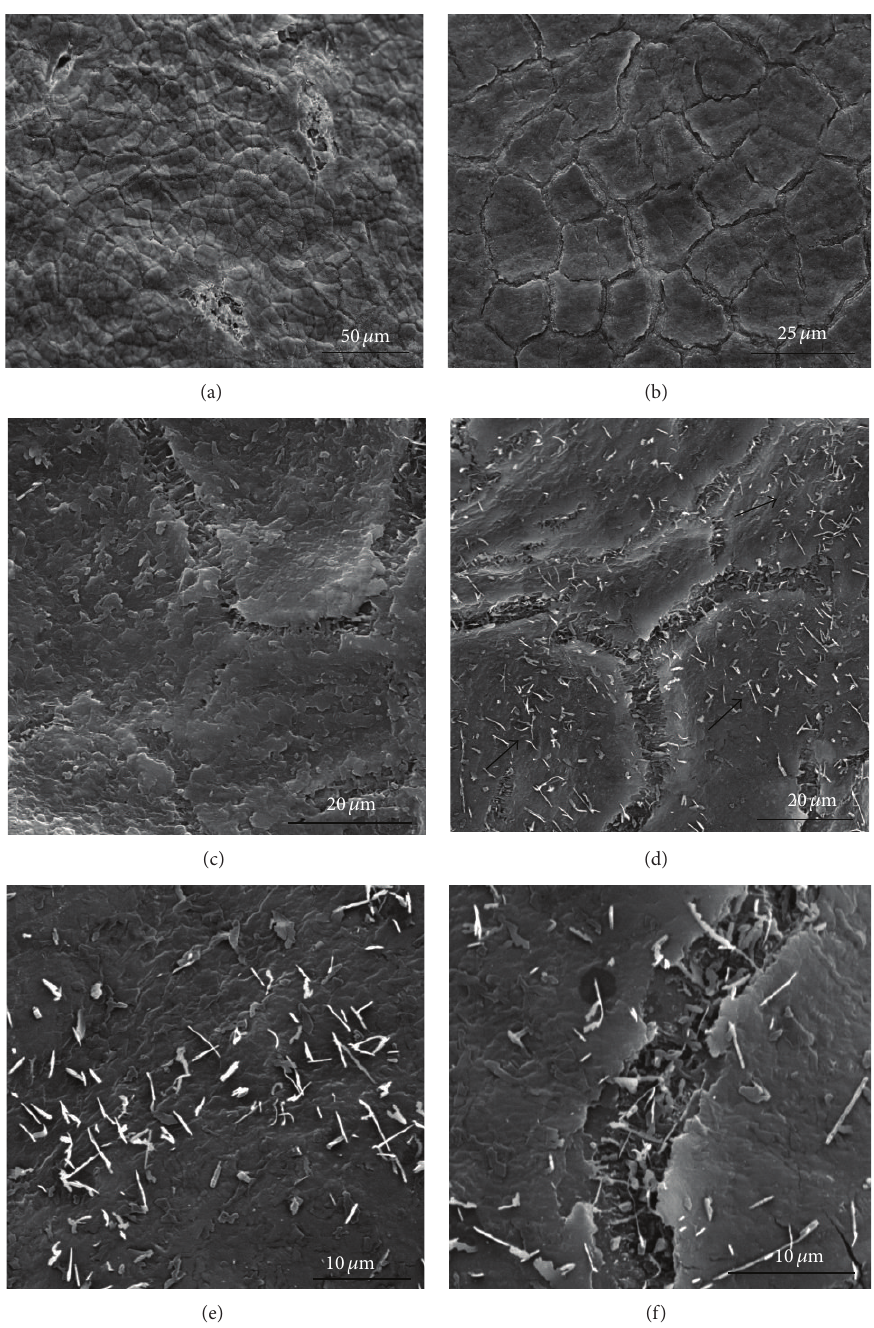
Figure 1: SEM: epidermis surface of the “Conference” ((a), (d)–(f)) and “Clapp’s Favourite” ((b), (c)) fruits at the fruit set stage. ((a), (b)) fragments of the epidermis surface with microcracks;((c), (d)) fragments of the epidermis surface with microcracks and horizontal (c) and vertical crystalline wax platelets (arrows) (d); (e) numerous vertical wax platelets between the microcracks; (f) microcracks with few vertical platelets of epicuticular